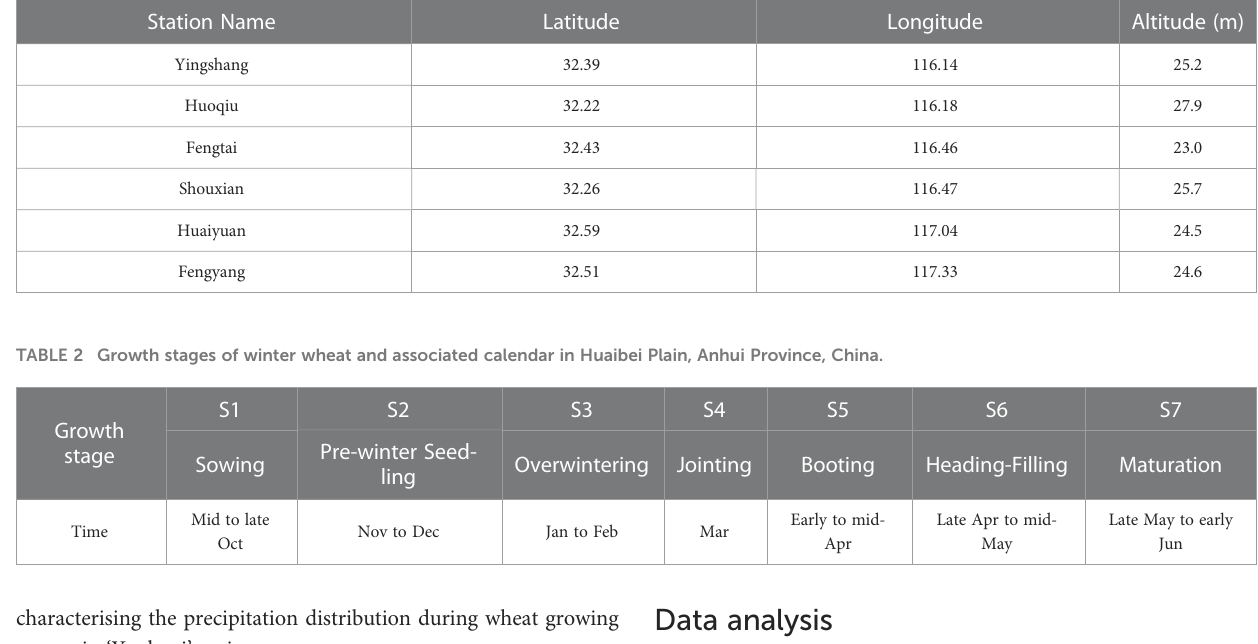
TABLE 1 Basic information of the six meteorological stations i.e. Yingshang, Huoqiu, Fengtai, Shouxian, Huaiyuan, and Fengyang in ‘ Yanhuai ’